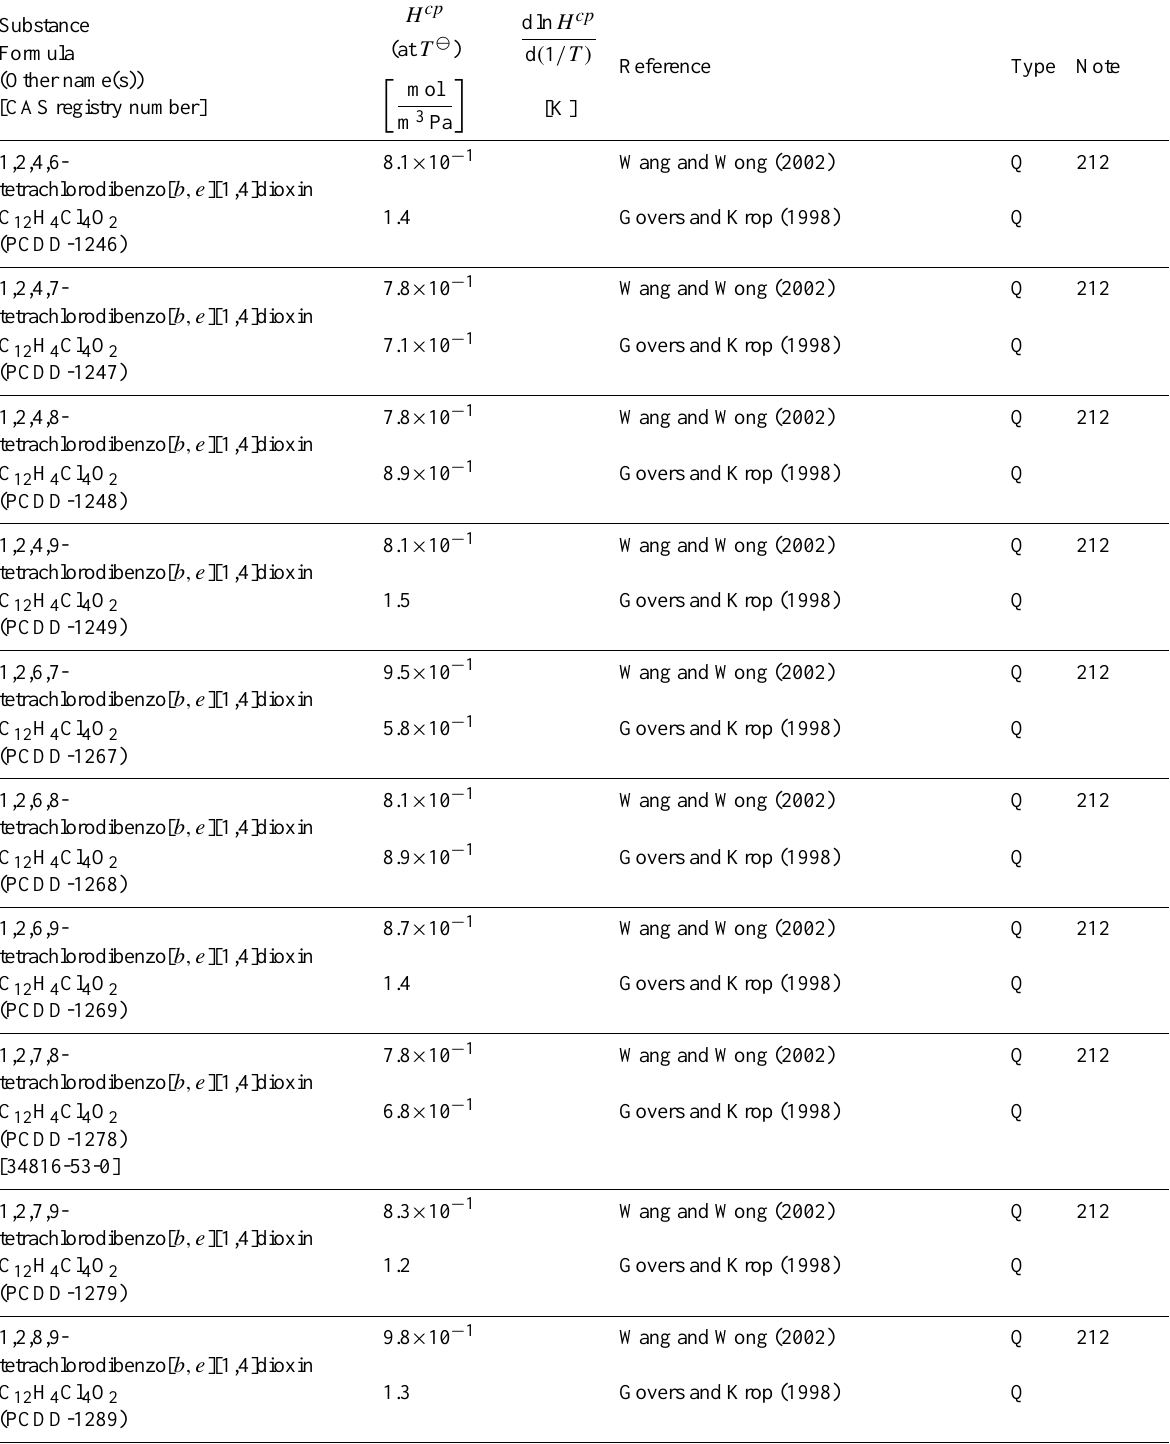
Table 6: Henry’s law constants for water as solvent